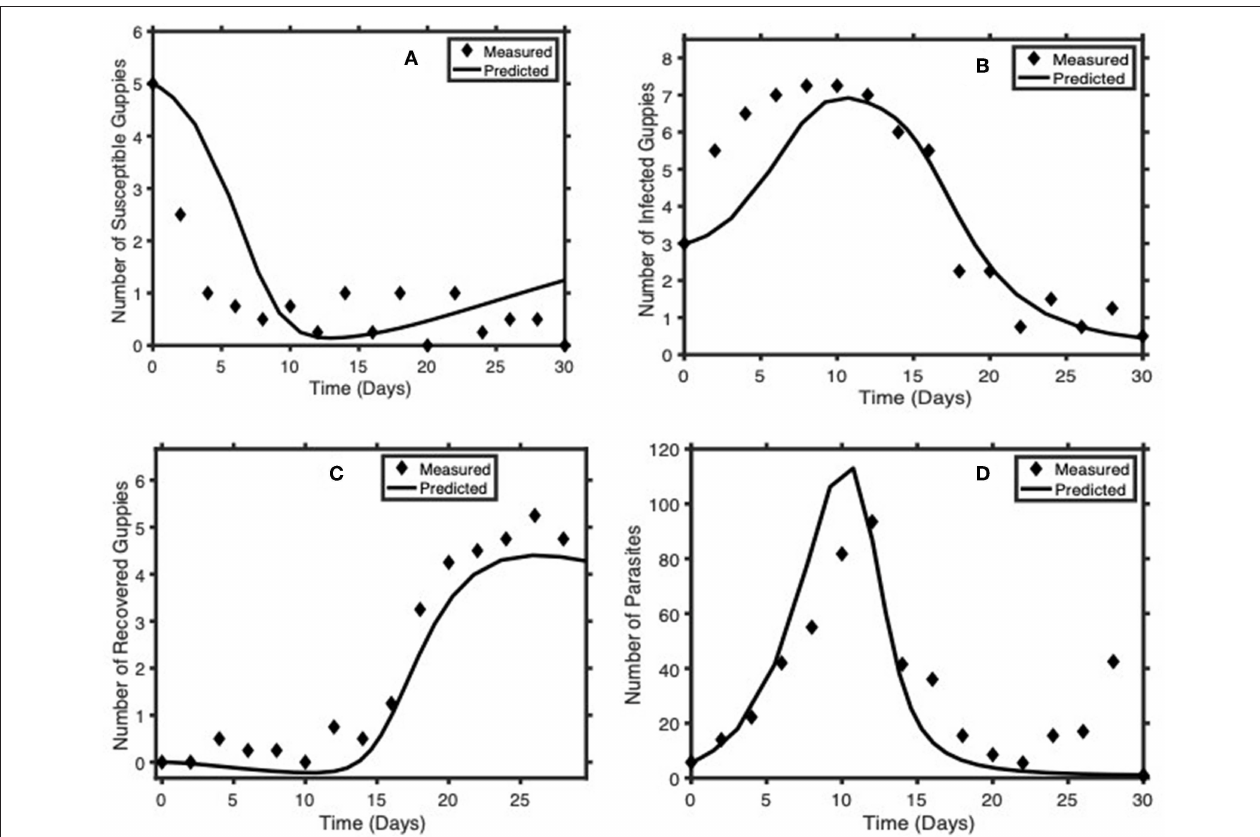
FIGURE 4 | Comparison of model predictions of Guppy- Gyrodactylus dynamics (solid lines) with averages from laboratory data (diamonds) independent from the data used to estimate the model parameters ( Table 1 ). (A–D) we have the time course dynamics of the number of susceptible guppies, infected guppies, recovered guppies and Gyrodactylus per tank,